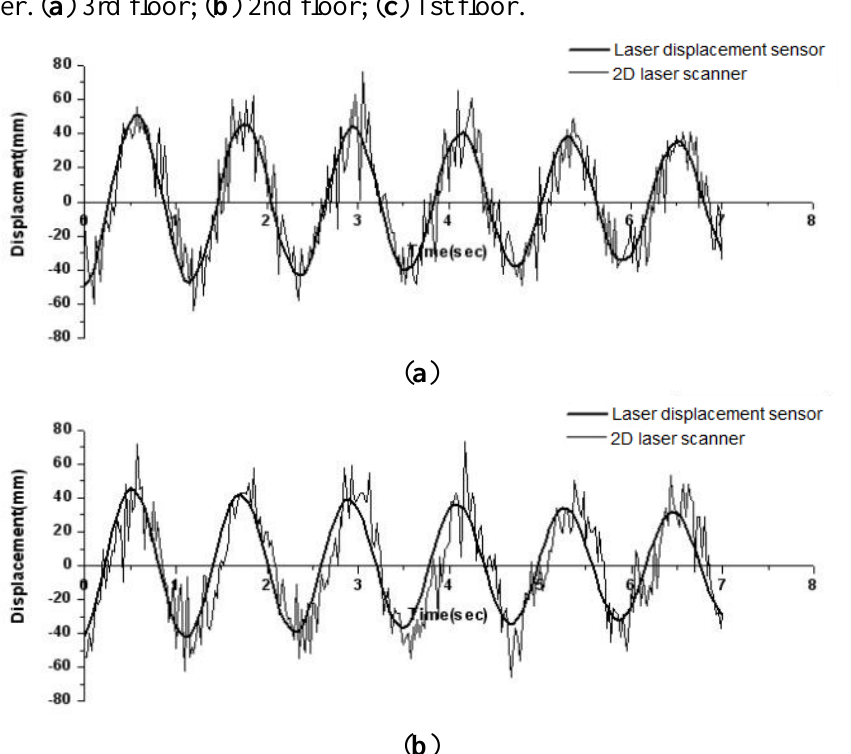
Figure 6. Displacement histories measured by laser displacement sensors and the